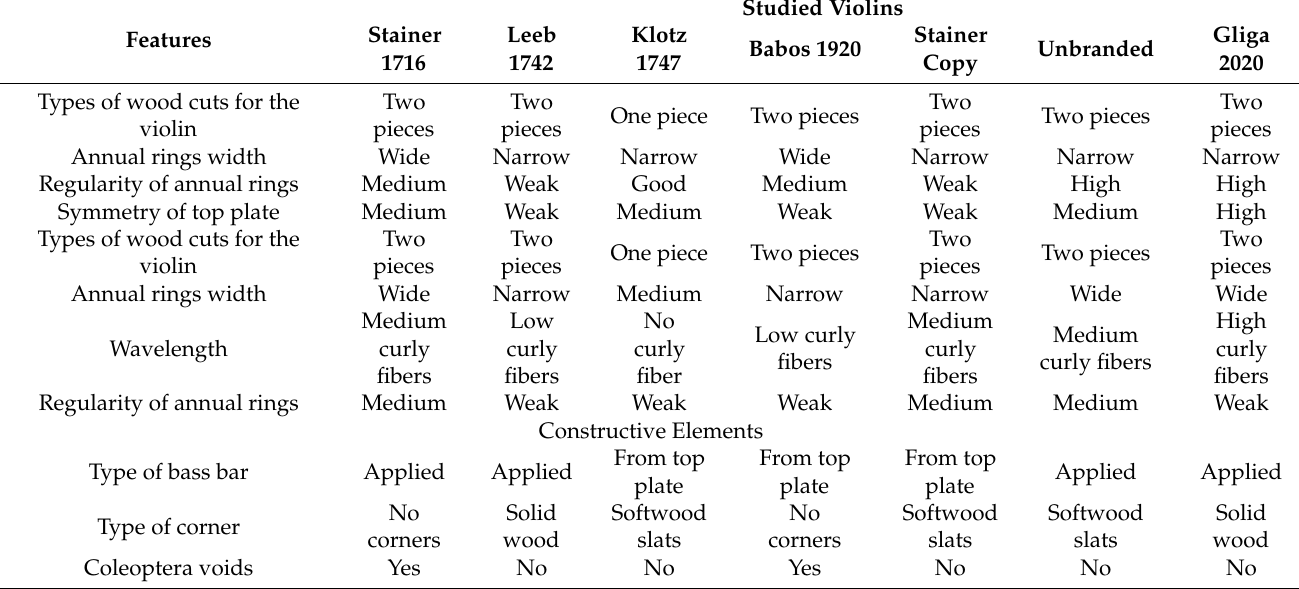
Table 2. The features of studied